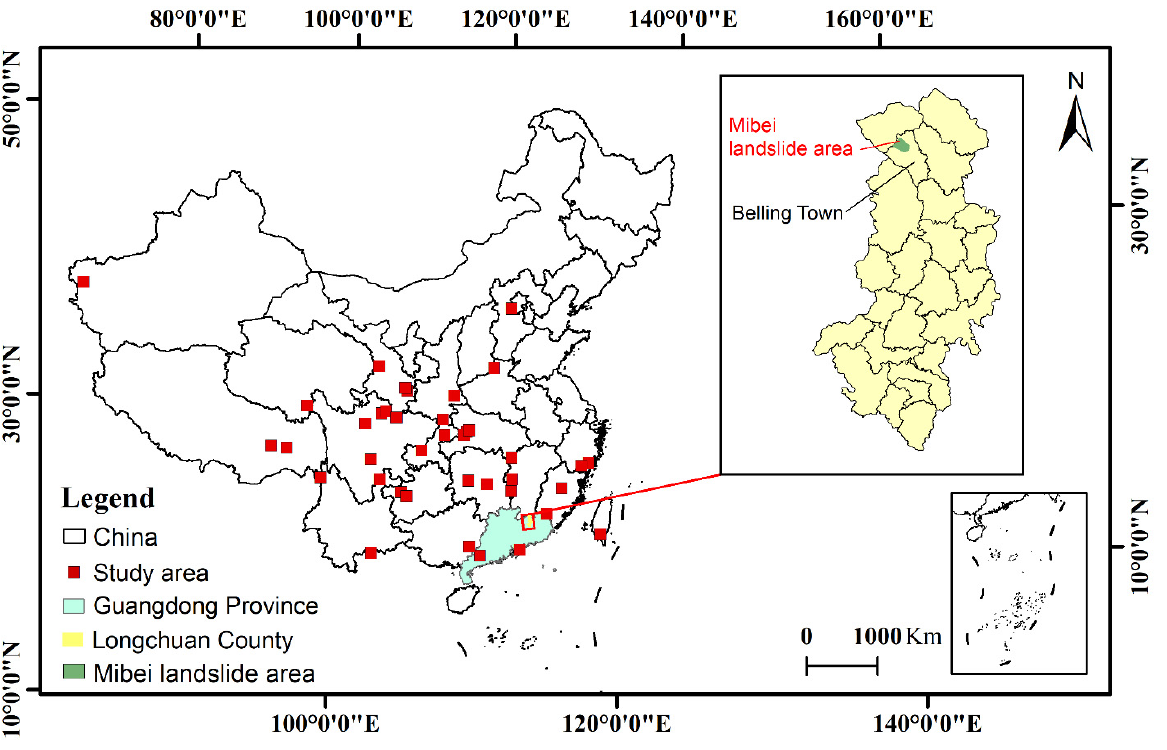
Figure 1. The location of the study area. The red rectangular boxes are landslide study areas, with multiple landslides distributed within each area.